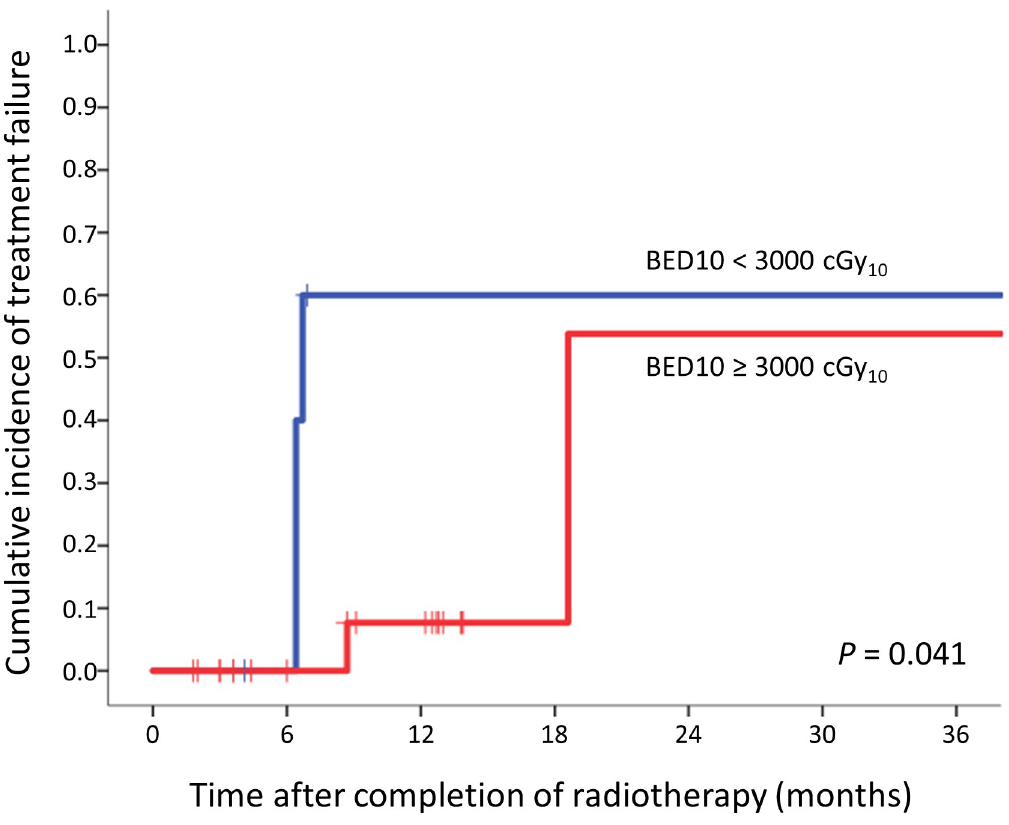
Fig 2. Kaplan-Meier curve for the cumulative incidence of treatment failure between radiotherapy dose � 3000 cGy 10 and < 3000 cGy 10 groups.